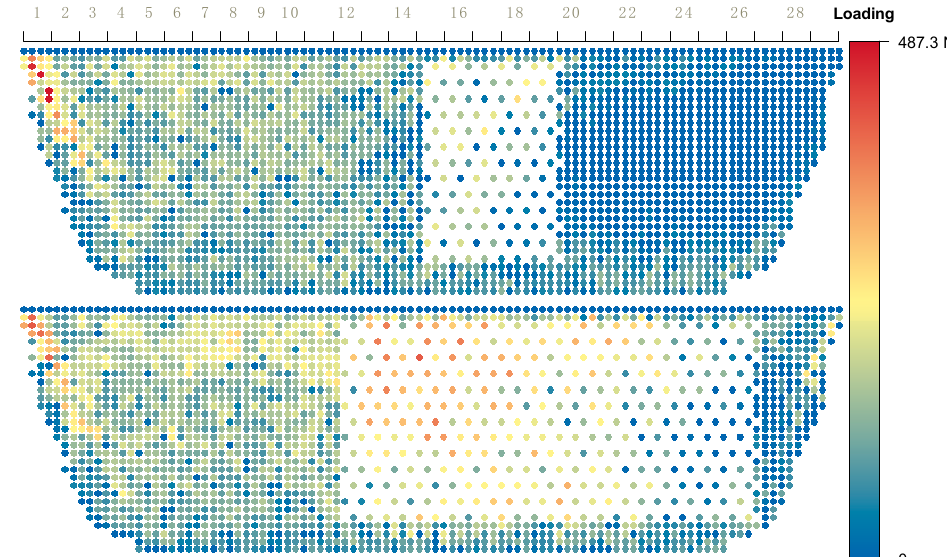
Figure 9. Load distribution at the end of shooting of two alternative nets with the mesh size doubled from the original mesh size of 260 mm across five successive strips from the 15th to 19th strips (top) and 15 strips from the 12th to 26th strips (bottom). The averaged breaking strength of strands was measured to be ca. 1700 N.